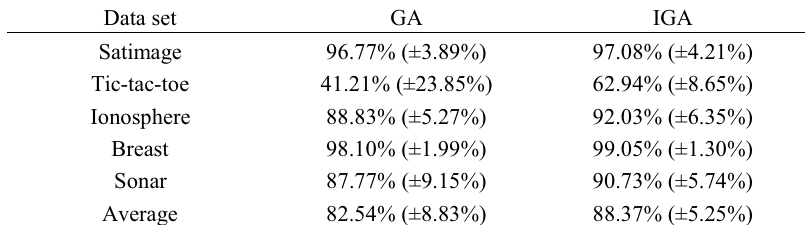
Table 4 Minority accuracies using the linear SVM after GA and IGA based feature